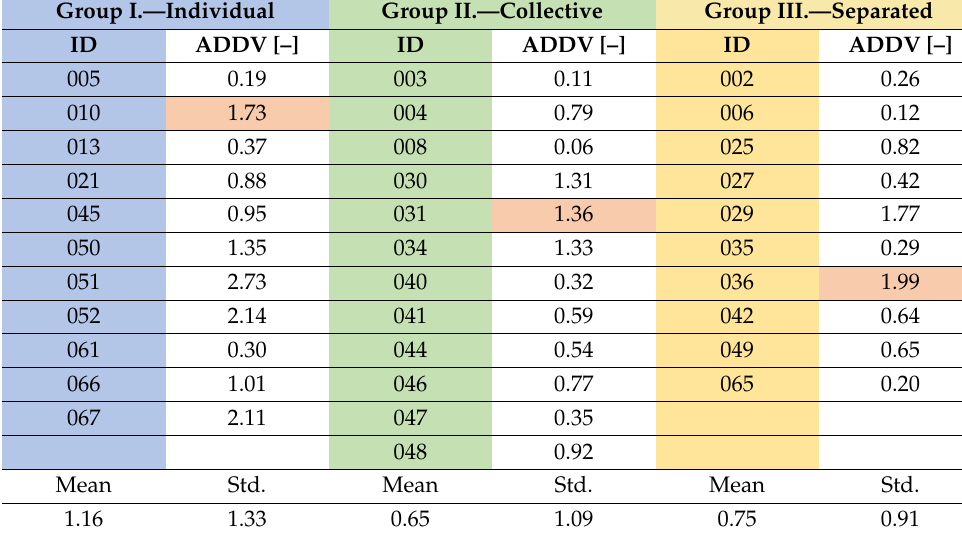
Table 2. Top: Average diameter difference in voxel dimensions (ADDV) for each case. Bottom: Mean and Std. values for each group. The cases highlighted with orange shading were excluded from the calcification analysis due to lack of any calcification.